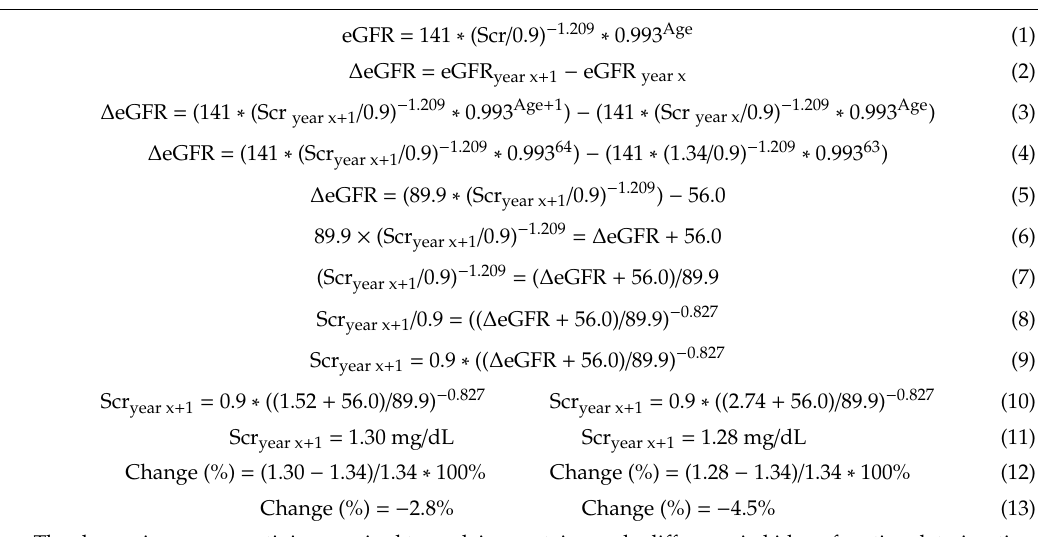
Box 1. Simplified calculation explaining the e ff ect of serum creatinine reductions, reflecting loss of muscle mass, on changes in estimated GFR over